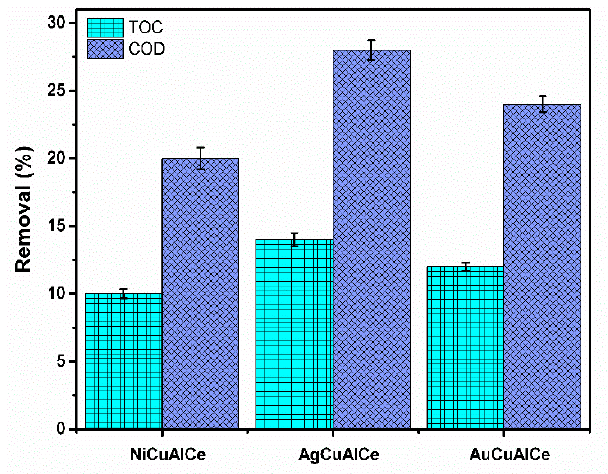
Figure 18. COD and TOC removal efficiency of petroleum refinery over bimetallic catalysts NiCuAlCe, AuCuAlCe, AgCuAlCe obtained after 180 min of reaction. Operation conditions T = 120 °C, P(O 2 ) = 10 bar, V Liq = 0.25 L, C Cat = 1 g L − 1 , ω = 1000 rpm.